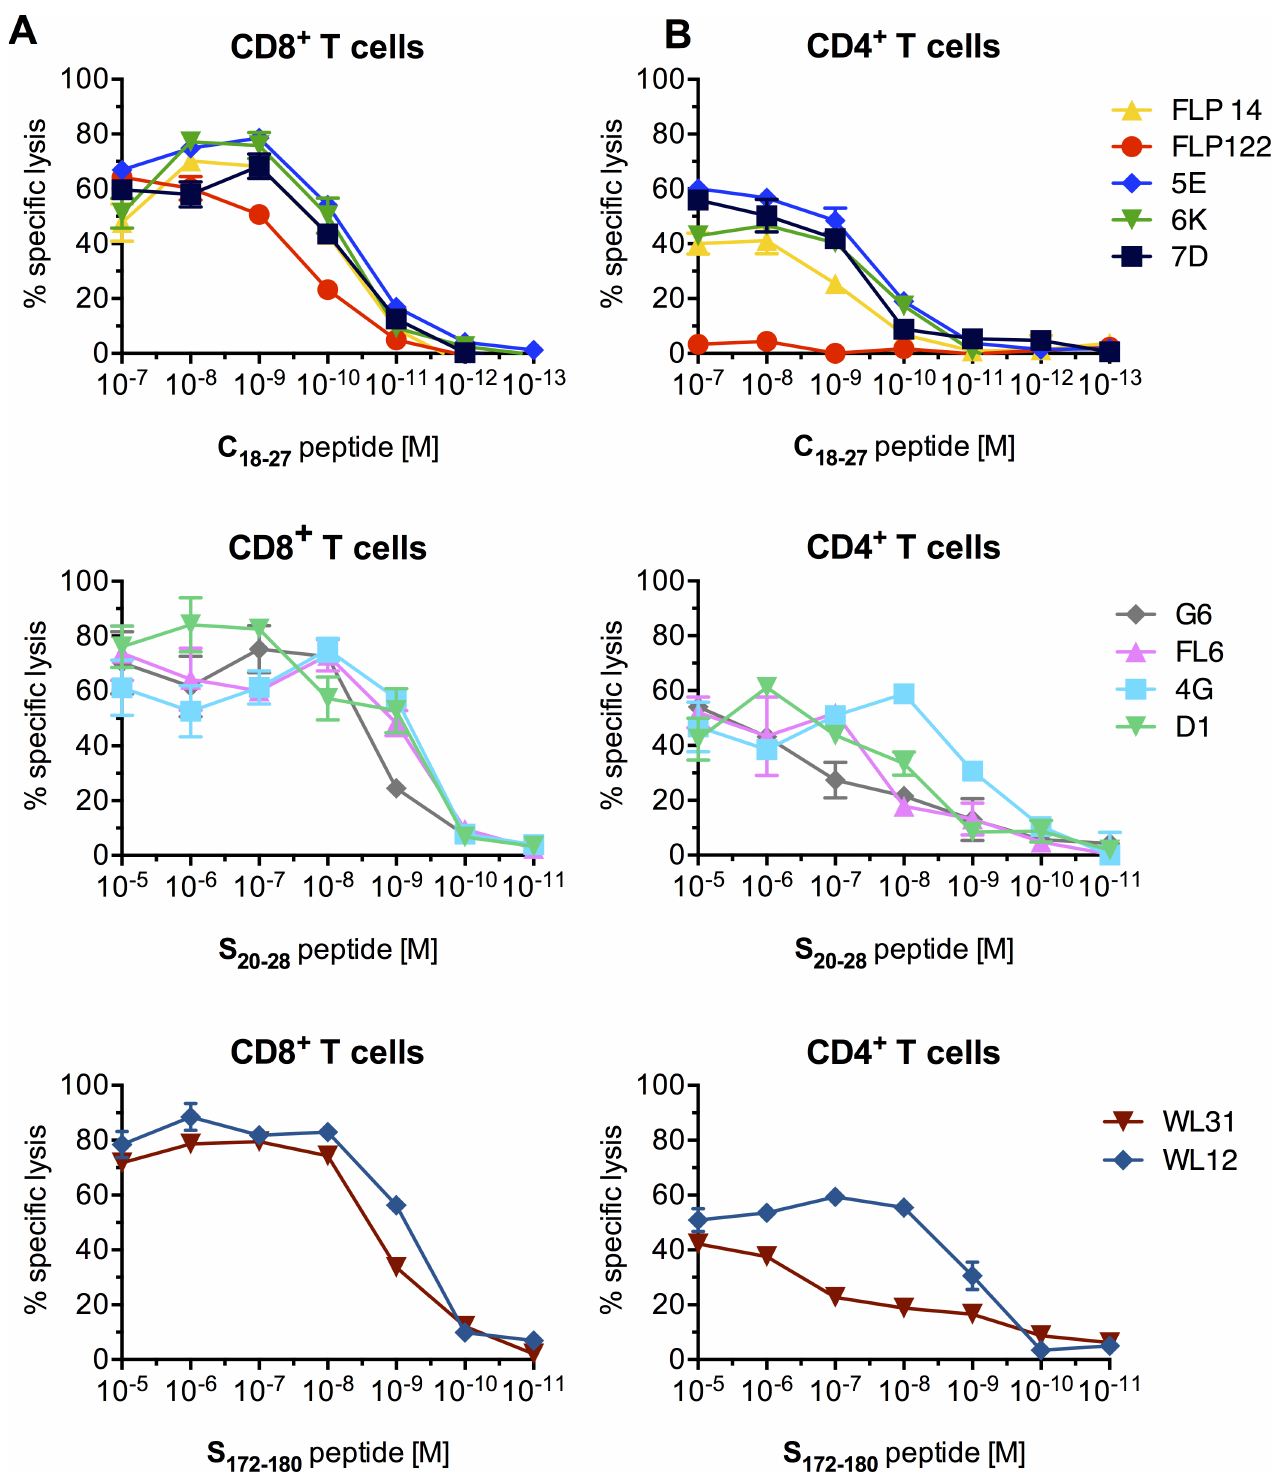
Fig 3. Sensitivity of TCR-transduced T cells. TCR-transduced CD8 + (A) or CD4 + (B) T cells expressingC18-specific, S20-specific, or S172-specific TCRs were co-cultured with T2 cells pulsedwith decreasing peptideconcentrations (effector to target ratio, E:T = 1:1). Each color representsone TCR. Cytotoxicityof effector cells was assessedby chromium release assay. Data are presented as mean values +/- SEM from triplicate co-cultures.